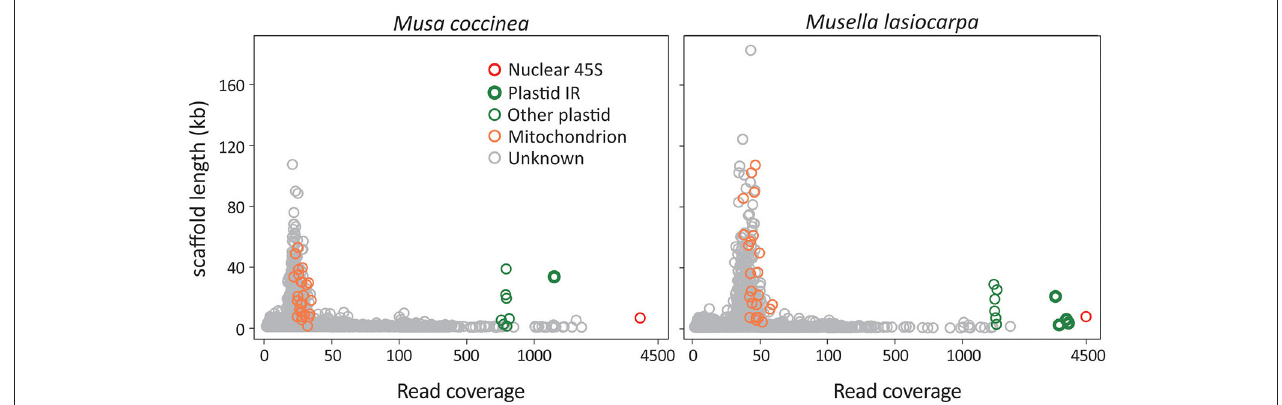
FIGURE 1 | Scatter plots of scaffold lengths vs. read coverage. Musa coccinea and Musella lasiocarpa are used as the representatives. Red, green, and orange circles indicate 45S rDNA, plastid, and mitochondrial scaffolds, while gray are “unknown” scaffolds that could not be identified using BLAST searches against our in-house database. Some plastid scaffolds are identified as IR regions because their read coverage is approximately double of the other plastid